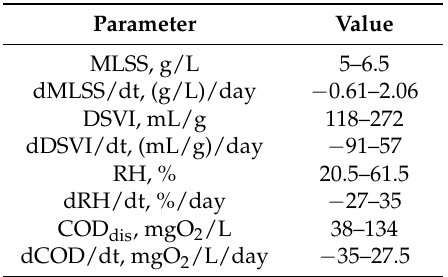
Table 3. Parameters of the mixed liquor in the separation chamber.